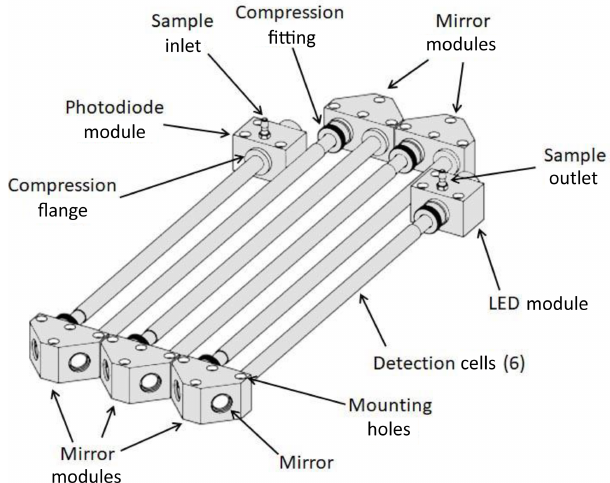
Figure 2. Perspective drawing showing the various modular com- ponents of a folded tubular